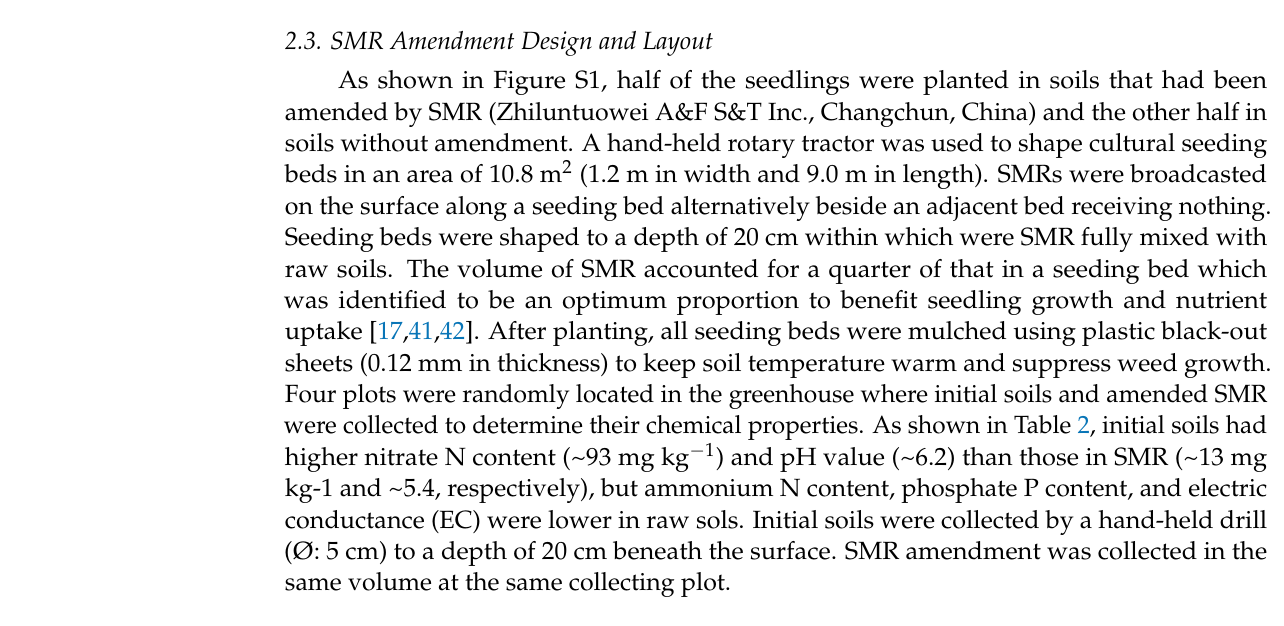
Table 2. Chemical properties in soils and spent mushroom residues (SMRs) for the culture of